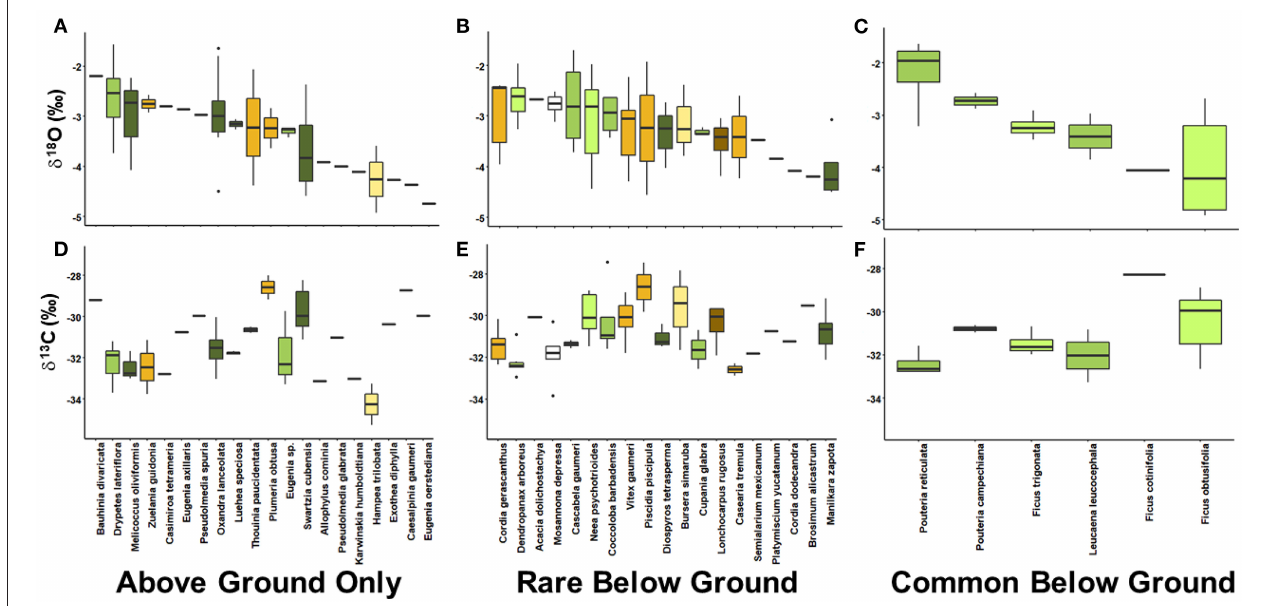
FIGURE 4 | Patterns in by stem water δ 18 O and leaf δ 13 C among species in the above ground only (A,D) , rare below ground (B,E) , and common below ground (C,F) groups. Colors reflect functional groups based on leaf habit (brown shades denote deciduous and green shades denote evergreen) and wood density (light to dark shades denote low to high wood density). Across all species, both δ 18 O and δ 13 C are significantly different ( δ 18 O: F 44, 97 = 1.57, p = 0.03; δ 13 C: F 44, 98 = 3.68, p <